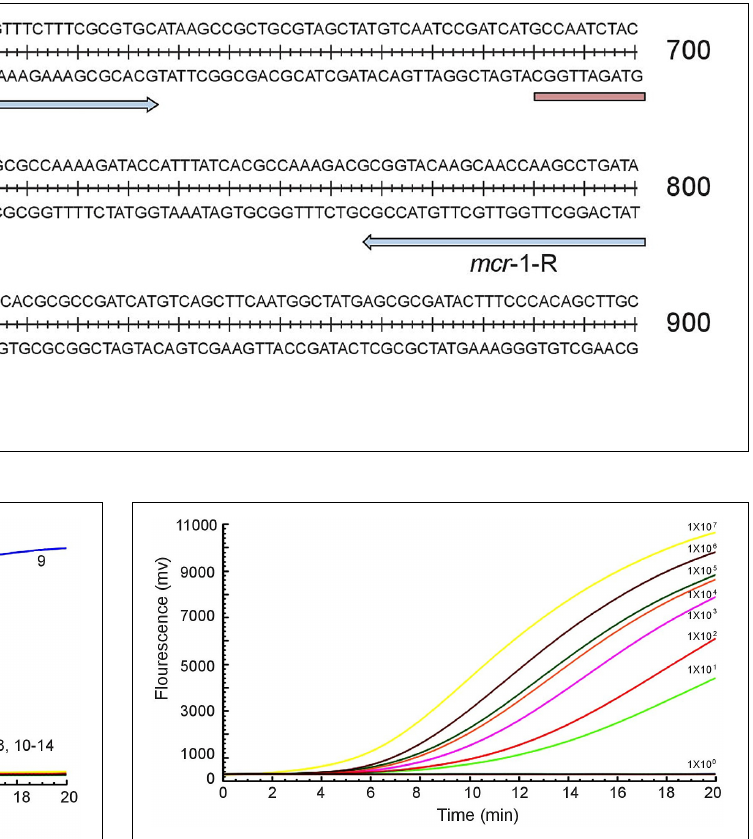
FIGURE 3 | Sensitivity of the RAA assay. An increase in the fluorescence signal was observed from 1 × 10 1 to 1 × 10 7